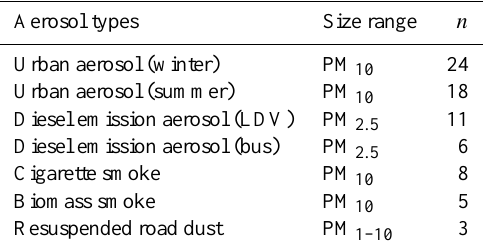
Table 1. Number of aerosol samples of various